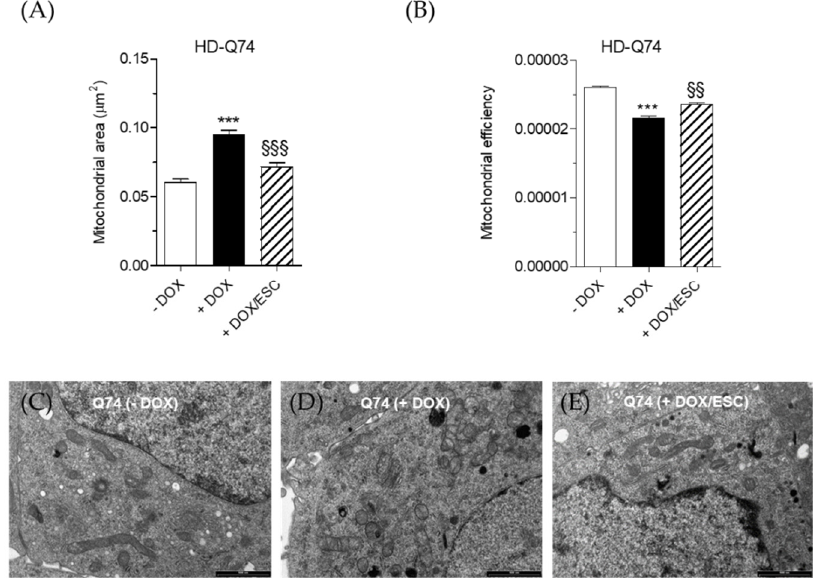
Figure 6. Effects of ESC on mitochondrial activity in HD-Q74 cells. Cells were incubated with DOX (1 µg/mL) for 3 days and ESC (5 µM) was added during the last 24 h of incubation with DOX. The mitochondrial area ( A ) and mitochondrial efficiency ( B ) were determined as described in the Materials and Methods. Data are reported as the mean ± SEM of at least three independent experiments (*** p < 0.001 vs. HD-Q74 ( − DOX), §§ < 0.01 and §§§ p < 0.001 vs. HD-Q74 (+DOX) at one-way ANOVA with Bonferroni post hoc test). ( C ) Ultrastructural TEM image of untreated HD-Q74 cells ( − DOX). Mitochondria showed a tubular shape with dense matrixes and regular cristae (scale bar: 1000 nm). ( D ) Ultrastructural TEM image of HD-Q74 cells induced with DOX (+DOX). Several mitochondria showed a round shaped morphology, extracted matrixes and swollen cristae (scale bar: 1000 nm). ( E ) Ultrastructural TEM image of HD-Q74 cells induced with DOX and treated with ESC (+DOX/ESC). Mitochondria showed a tubular shape, with dense matrixes and regular cristae (scale bar: 1000 nm).